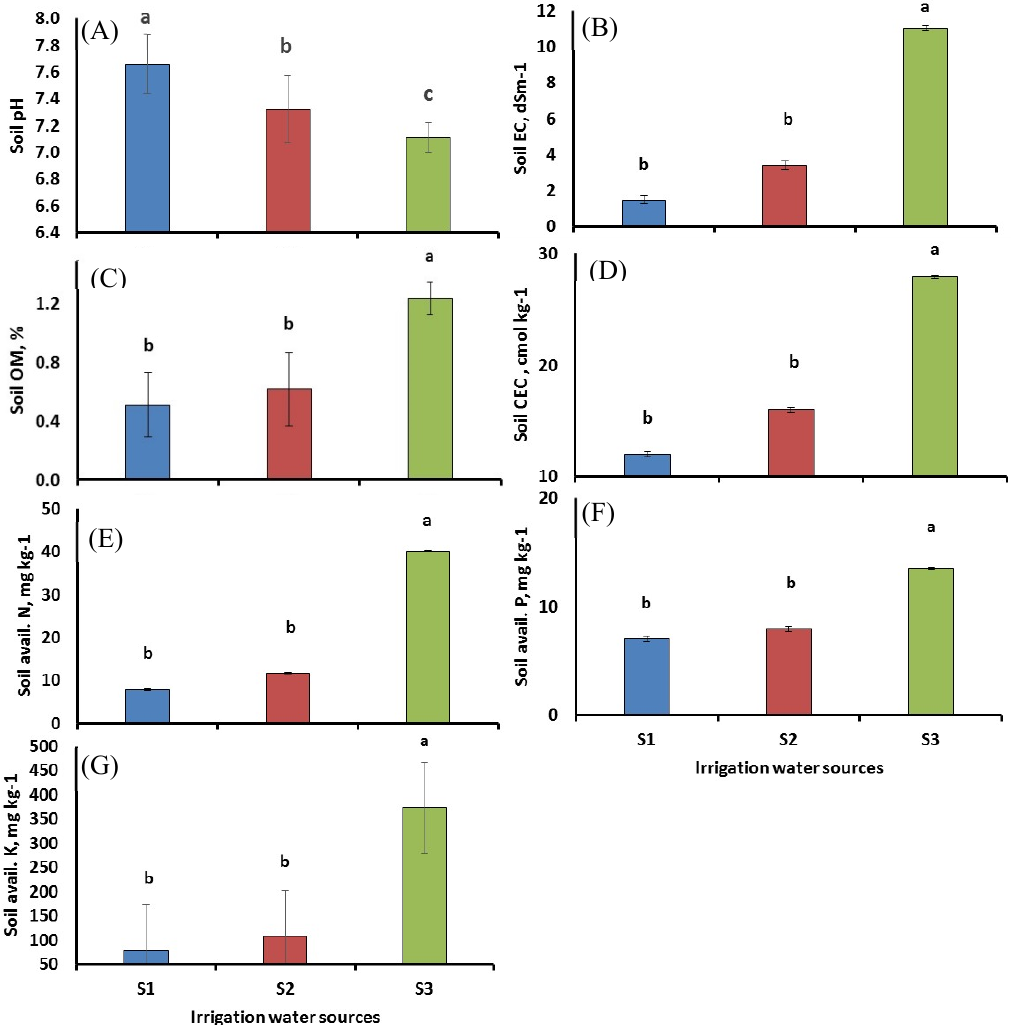
Figure 4. Effect of different water sources (S1, S2, and S3) on chemical properties of the studied soil profiles using variance analysis: ( A ) soil pH, ( B ) soil EC, ( C ) soil OM, ( D ) soil CEC, ( E ) soil available N, ( F ) soil available P, and ( G ) soil available K. Values are presented as means ± standard deviation (SD) using number of the studied soil profiles ( n = 12). For each attribute, bars with different superscript letters (a, b, and c) denote significant difference between the effects of types of irrigation water at p < 0.05. Appearance of the same letter means that the difference was not